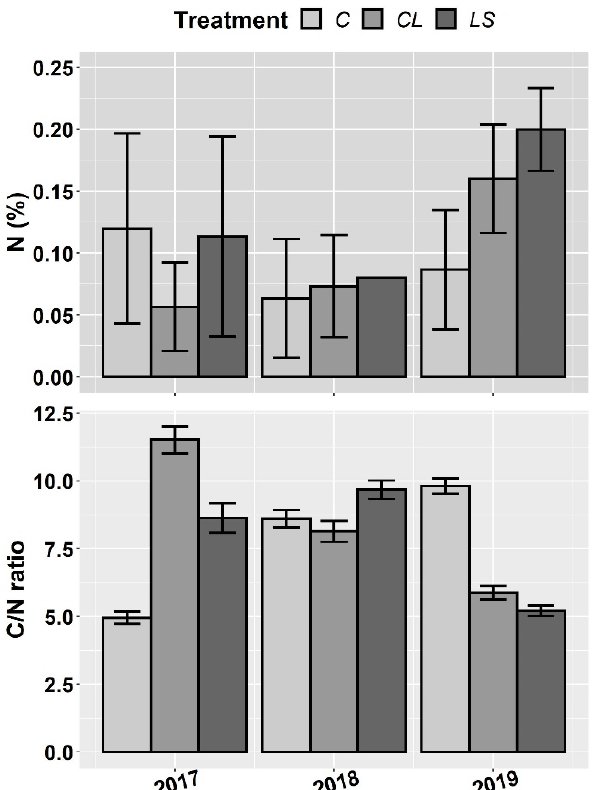
Figure 3. Mean values of the soil parameters nitrogen (N) and C/N ratio for each treatment and year. Treatments: control (C), control of leonardite (CL), and leonardite mixed with ferrous sulphate heptahydrate (LS). Error bars reflect the SE of the mean ( ± 1 SE mean).